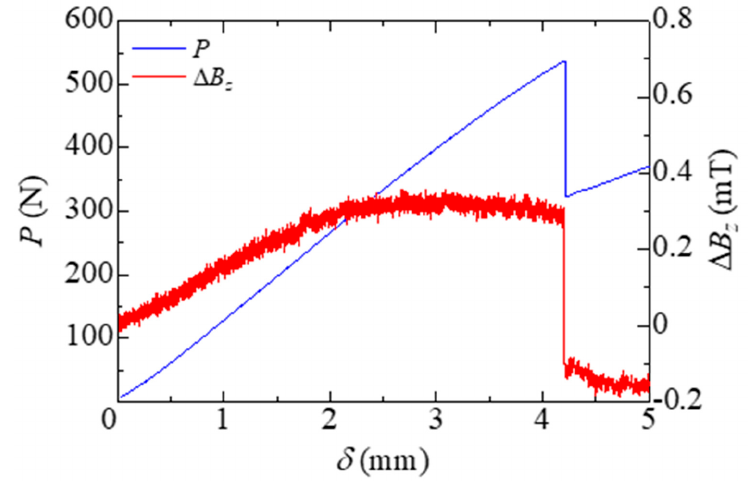
Figure 5. Load P and magnetic flux density change Δ B z versus load point displacement δ .